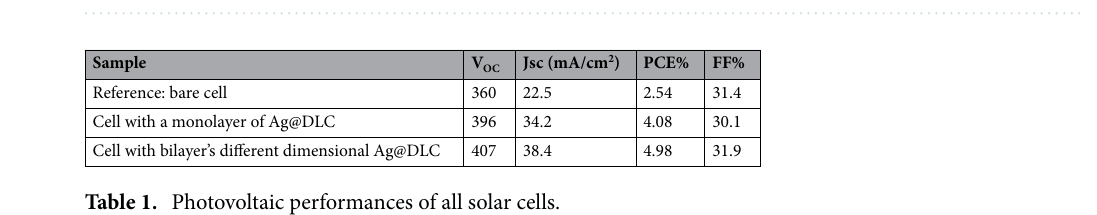
Figure 5. ( a ) Photovoltaic J–V curves of bare cell, monolayer and bilayer Ag nanoparticles solar cells under AM 1.5 solar radiation, ( b ) comparison of the Jsc.